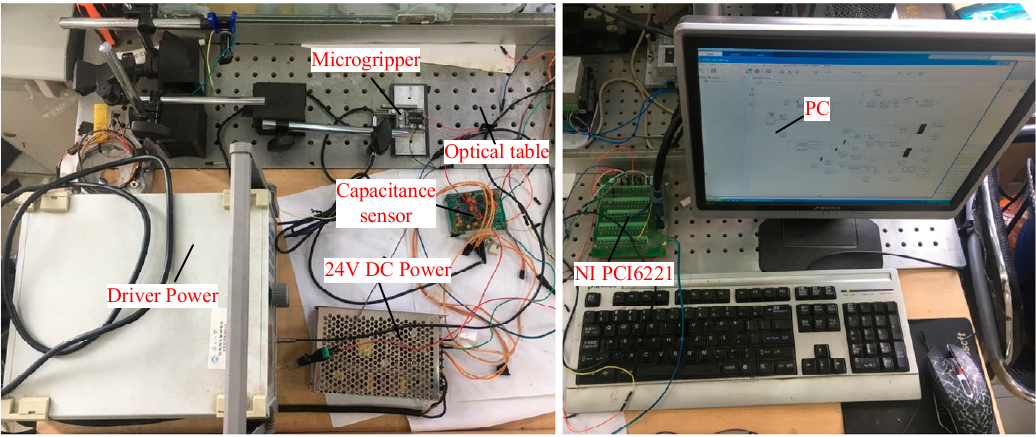
Figure 9. Experimental setup of the microgripper.